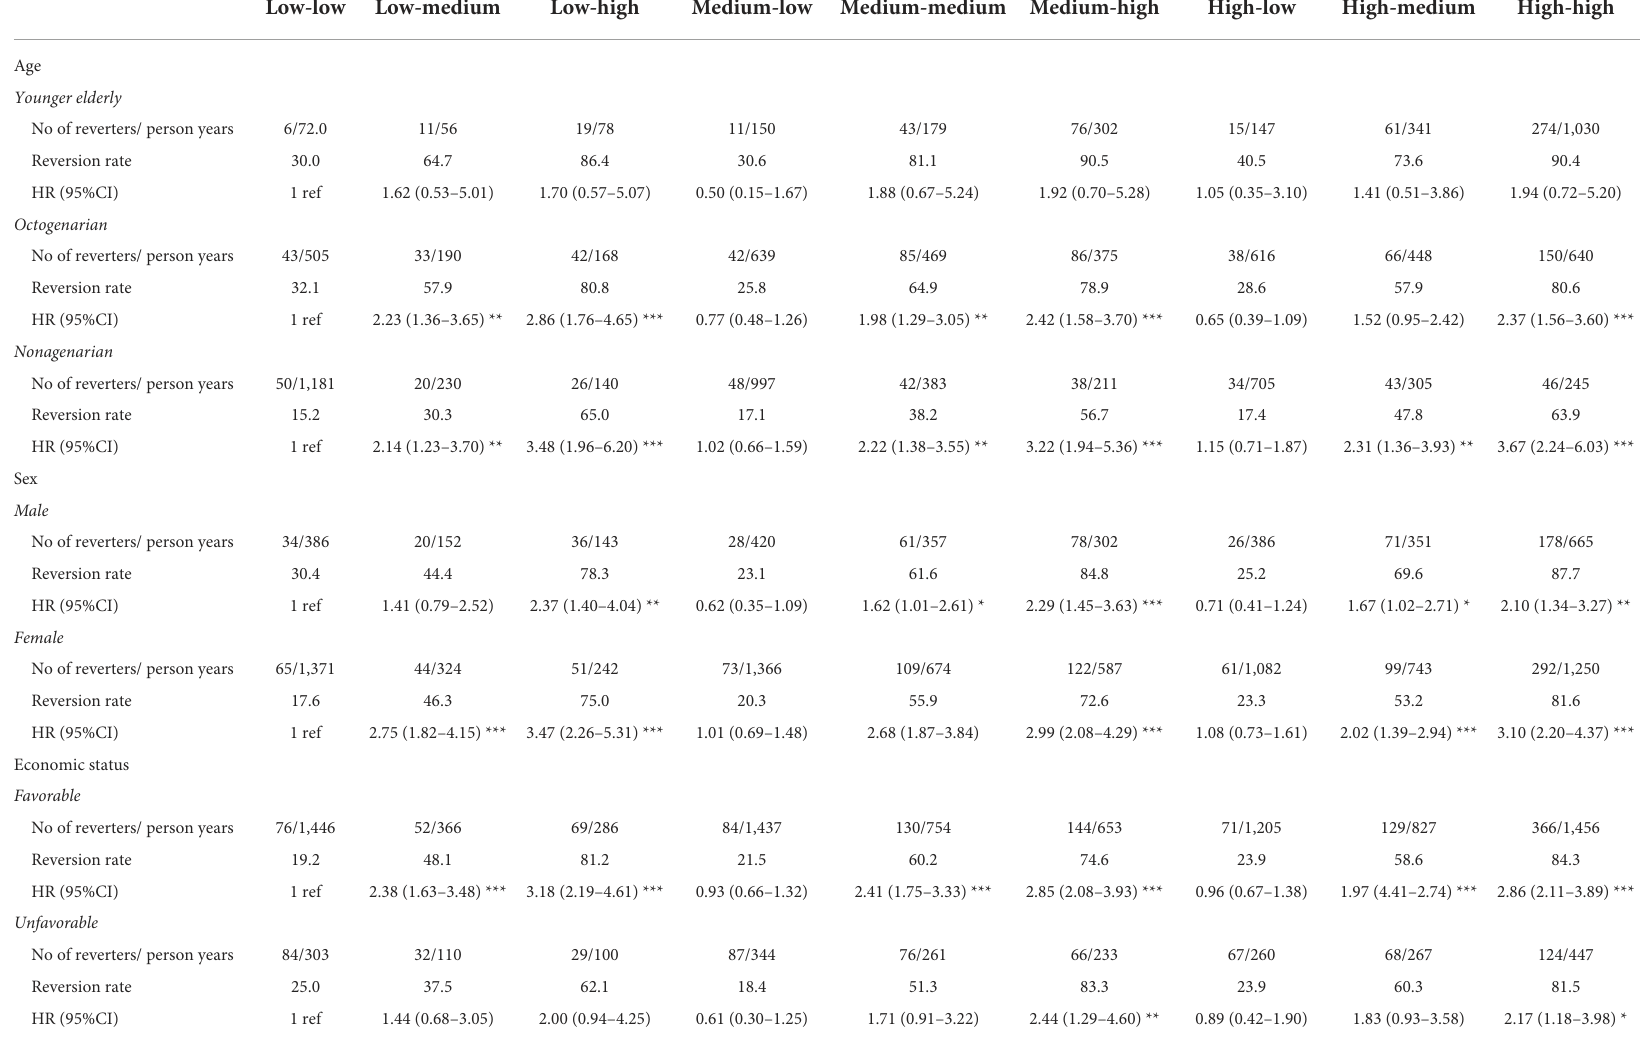
TABLE 4 The association between LAE change patterns and MCI reversion in